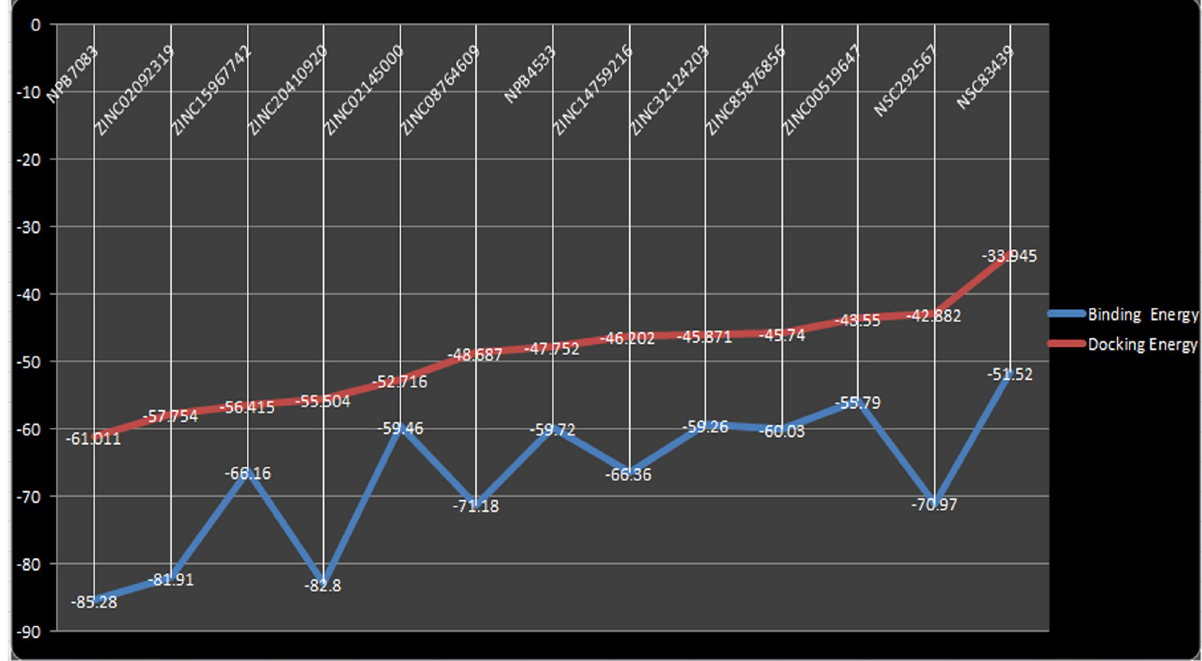
Fig 7. Docking energy and binding energy comparison of screened compounds.